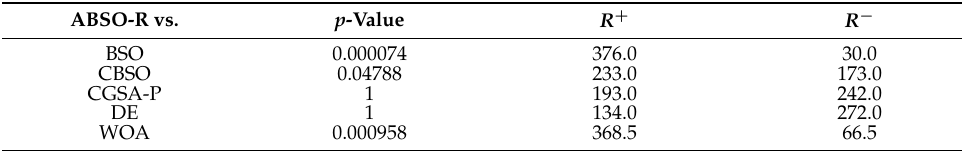
Table 3. Wilcoxon statistical test results of ABSO-R.